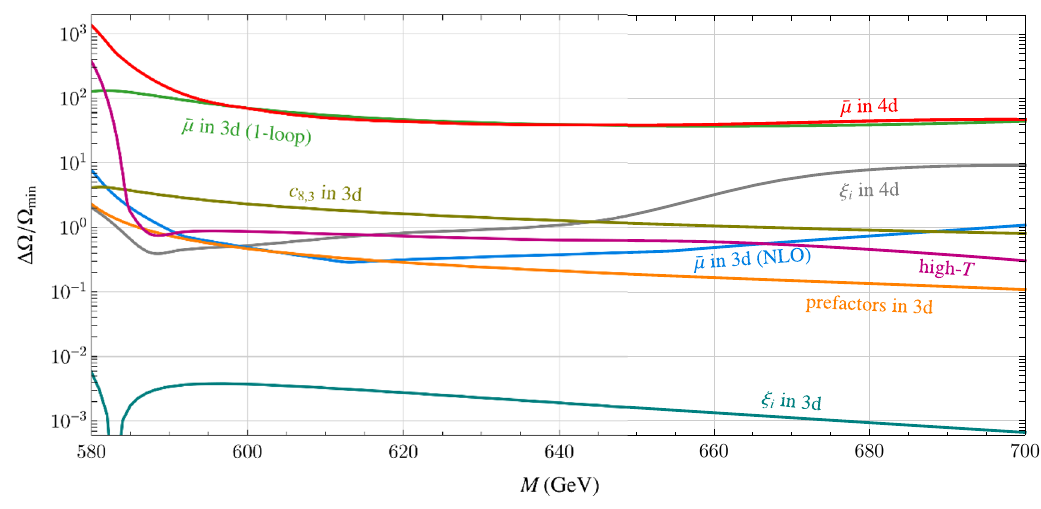
Figure 10 . Effects of variation for different sources of theoretical uncertainty on the parameter ∆Ω / Ω min , defined in (3.1). The renormalisation scale is varied between ¯ µ = gauge parameters are varied in the range ξ = chartreuse line labeled “ c 8 , 3 in 3d” gives the difference between the result including that parameter and the result with only c 6 , 3 . The purple line labeled “high- T ” gives the variation due to the high- temperature expansion of the thermal functions J nonperturbativity and due to the breakdown of the derivative expansion in the 4d approach are not included in this plot, as we were unable to give reliable and detailed estimates of the magnitude of these